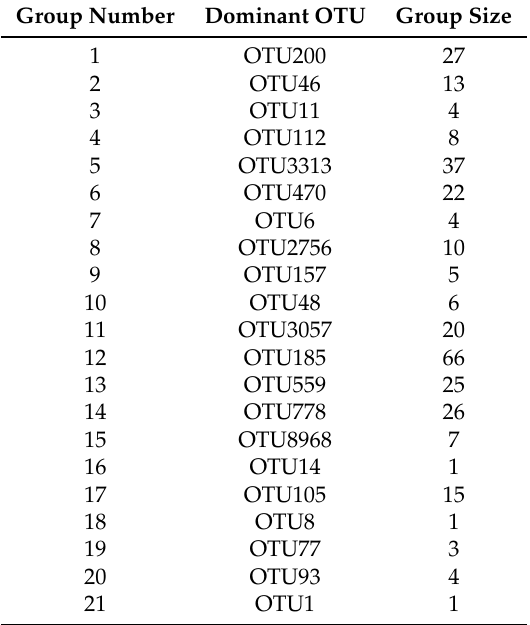
Figure 17. Membership for the AIC-optimal GMM model with K = 21 clusters. Table 3. Dominant OTUs from Gaussian mixture